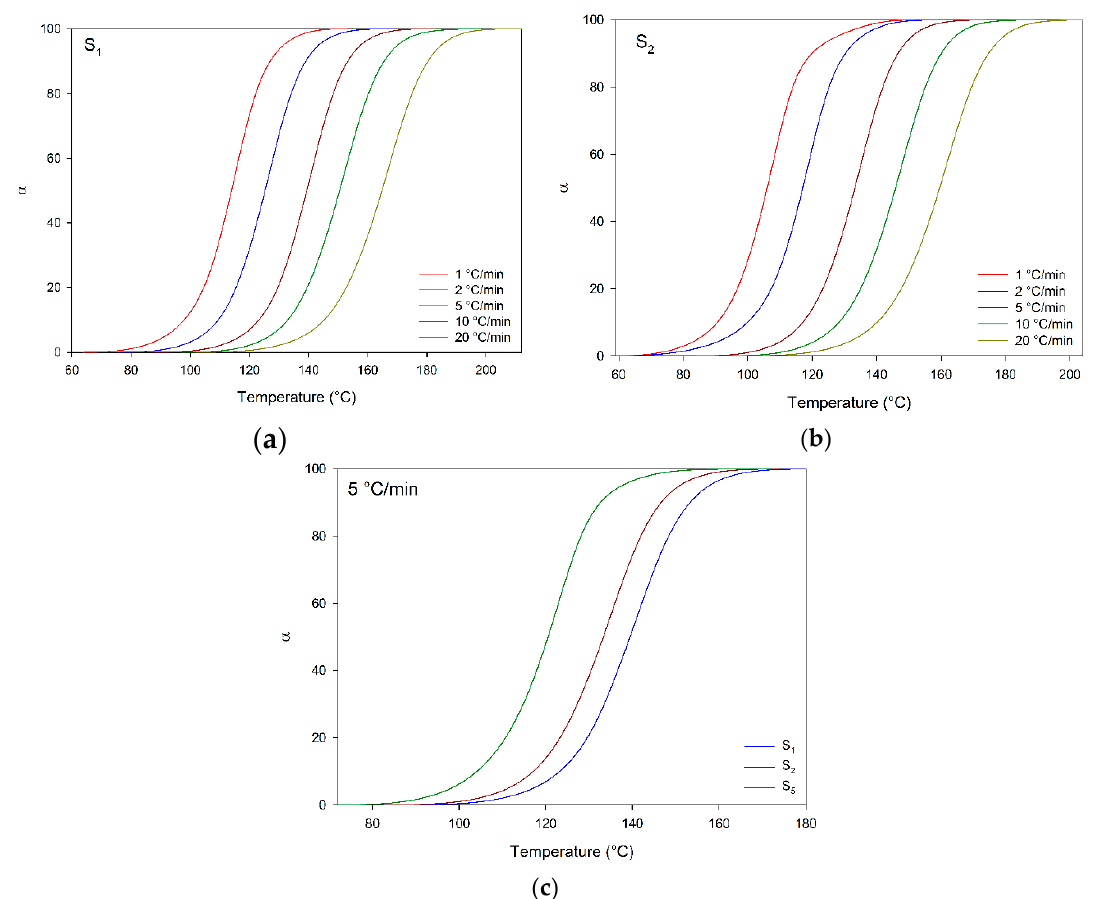
Figure 5. Cure conversion of benchmark compounds (S x ). ( a ) S 1 , ( b ) S 2 , ( c ) S 1 , S 2 , and S 5 computed at 5 °C/min.